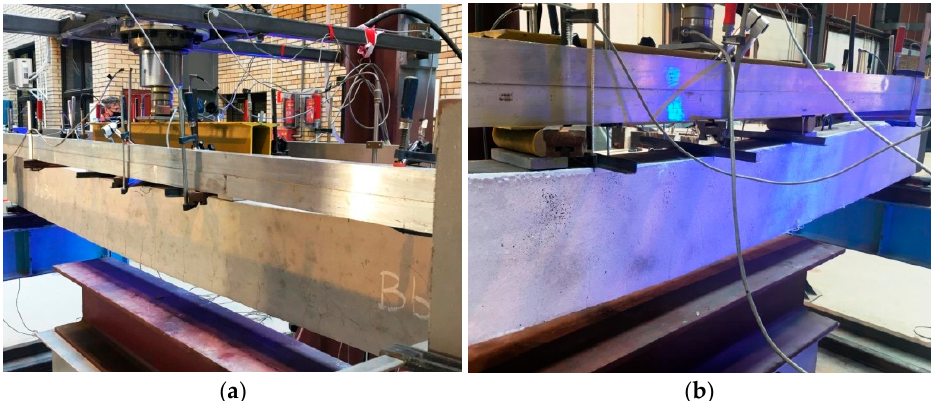
Figure 9. Beams under loading—views along the elements: ( a ) A beam without the polyurea coating; ( b ) a polyurea-coated beam.